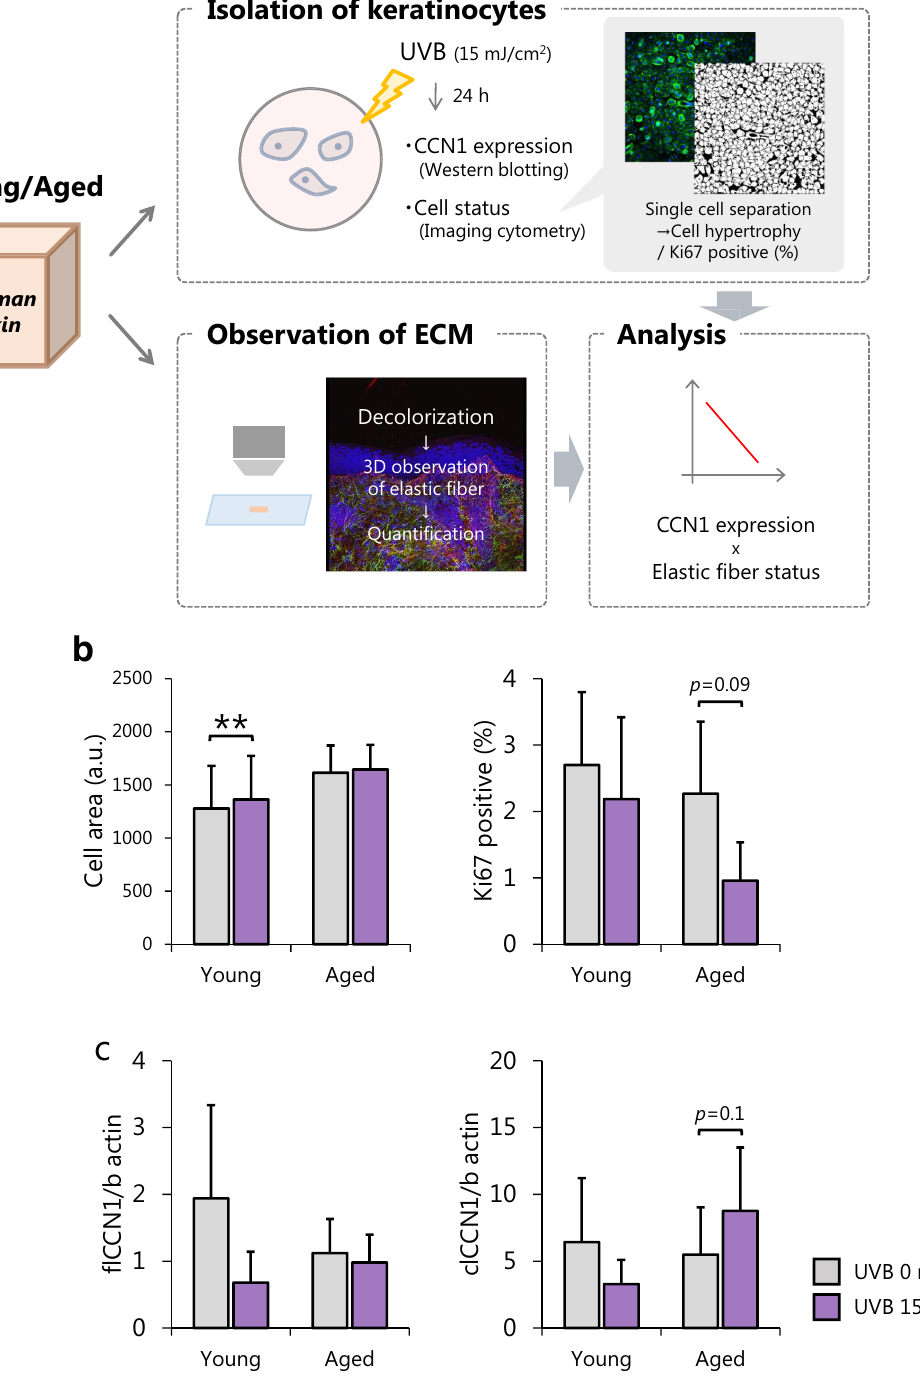
Figure 4. Epidermal CCN1 is increased by UVB exposure especially in aged keratinocytes and deteriorates the structure of elastic fibers in human skin. Overview of the experimental method ( a ). Cell area and Ki67- positive rate of isolated keratinocytes determined by imaging cytometry ( b ) and CCN1 expression (flCCN1: 42 kDa full length CCN1, clCCN1: 25 kDa secreted CCN1) in keratinocytes determined by Western Blots 24 h after 0 or 15 mJ/cm 2 UVB irradiation. Values reported are means ± SD of n = 4 or 6, Student’s t test, ** p < 0.01 ( c ). Volume of elastic fibers determined by immunohistochemistry of decolorized skin and structural analysis ( d ). Correlation analysis between clCCN1 expression and the volume of elastic fibers performed by Pearson’s correlation test, n = 10 ( e ). Expression of clCCN1 in keratinocytes derived from volunteers with higher or lower elastin volumes. Values reported are means ± SD of n = 5, Student’s t test, * p < 0.05 ( f